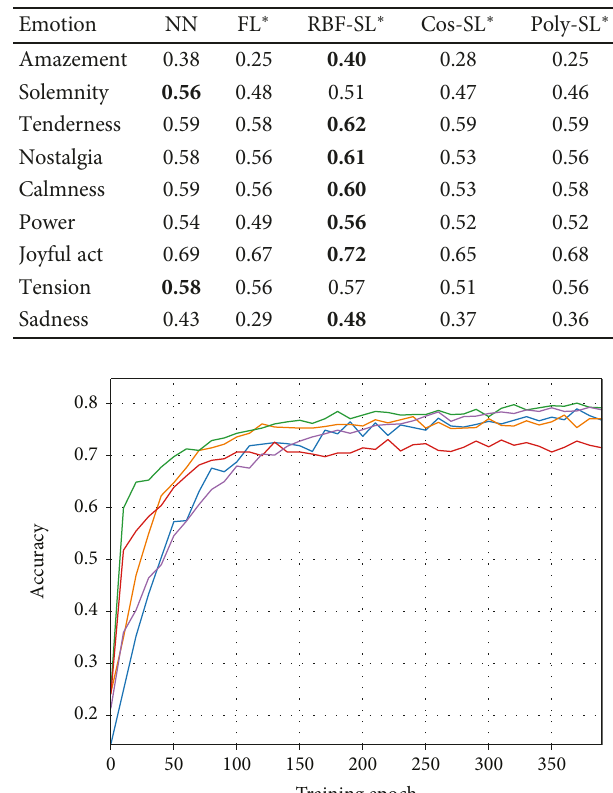
Table 2: Pearson ’ s R on the Emotify dataset. Asterisk denotes SVM use.